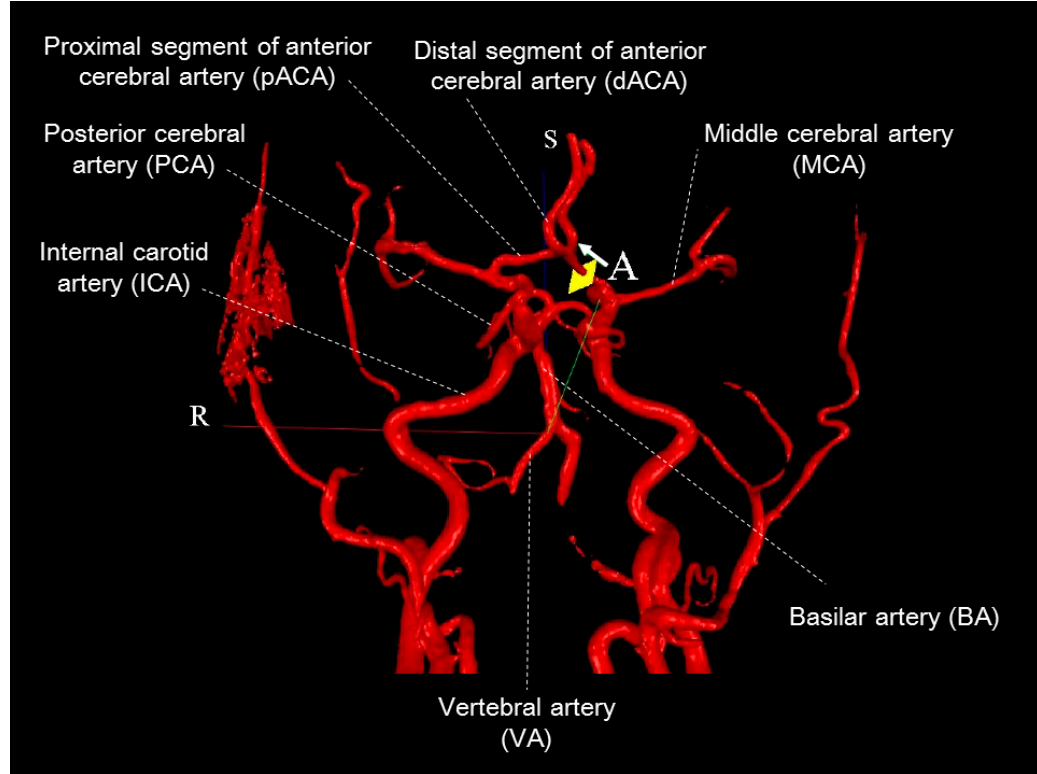
Figure 2. Magnetic resonance angiogram of cerebral arteries for non-invasive optimal vessel analysis (NOVA). Blood flow volume measures were performed on a plane (square cutting area) perpendicular to the plane of blood flow (arrow) in the vessels. The flow curve is also shown. The distal and proximal segments of the anterior cerebral arteries were defined as distal and proximal to anterior communicating artery, respectively. A, anterior; R, right; S, superior. Table 2. Flow measurements by two radiology technologists.